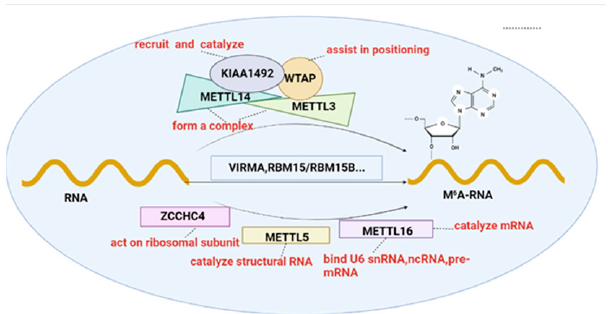
Figure 1. Mechanism of action and functions of methyltransferases. Methyltransferase is also responsible for the methylation of m 6 A. METTL3 and METTL14 usually form a complex, which is then combined with WTAP to locate. KIAA1492 is another auxiliary catalytic enzyme. ZCCHC4, METTL5, and METTL16 play independent catalytic functions on ribosomal subunits, structural RNA, and snRNA, respectively. Studies have shown that methyltransferase-mediated m 6 A modifications, particularly METTL3 and METTL14, are associated with the occurrence of a variety of cancers, including gastric, prostate, breast, colon, pancreatic, kidney, mesothelioma, sarcoma, and leukemia. Among them, gastric cancer (GC) is the fifth most prevalent type of cancer and the third leading cause of cancer-related death worldwide [9]. A recent study showed that the H3K27ac modification of METTL3 in the promoter region is regulated by p300, which in turn induces transcriptional activation of METTL3 and catalyzes the m 6 A modification of GC-associated HDGF genes. This enables IGF2BP3 to directly bind the m 6 A site on HDGF, maintaining gene stability and accelerating the progression of GC [4]. Furthermore, METTL3 promotes GC angiogenesis and progression through the m 6 A-YTHDF2-dependent pathway to reduce the stability of ADAMTS9 mRNA by activating the PI3K/AKT signaling pathway